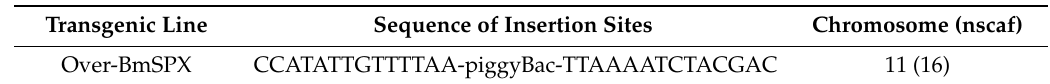
Table 1. Insertion site of Over-BmSPX